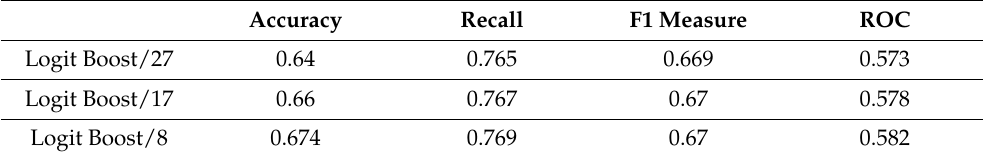
Table 8. Evaluation of results of classification with all 27, 17, and 8 parameters using LogitBoost.